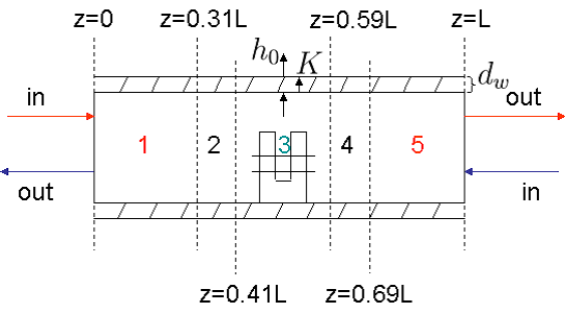
Figure 1. A simplified picture of RFR with switching time and compartments. 1 and 5 are inlet parts, 2 and 4 are catalyst parts, and 3 is a heat exchanger part. In this case, L 1 = 0 . 31 L , L 2 = 0 . 41 L , L 3 = 0 . 59 L and L 4 = 0 . 69 L